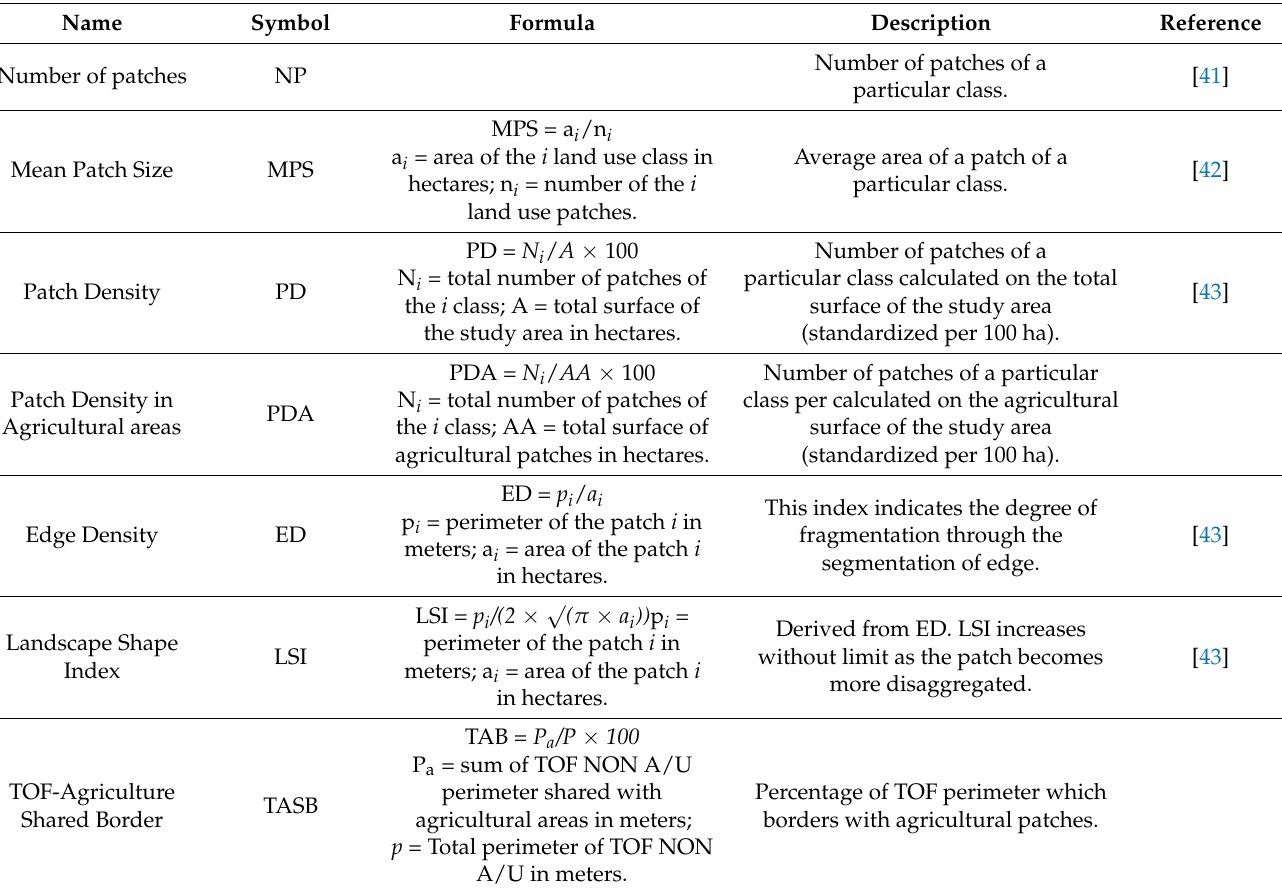
Table 1. Landscape metrics applied for the evaluation of the role of TOF NON A/U in the Colline del Prosecco UNESCO